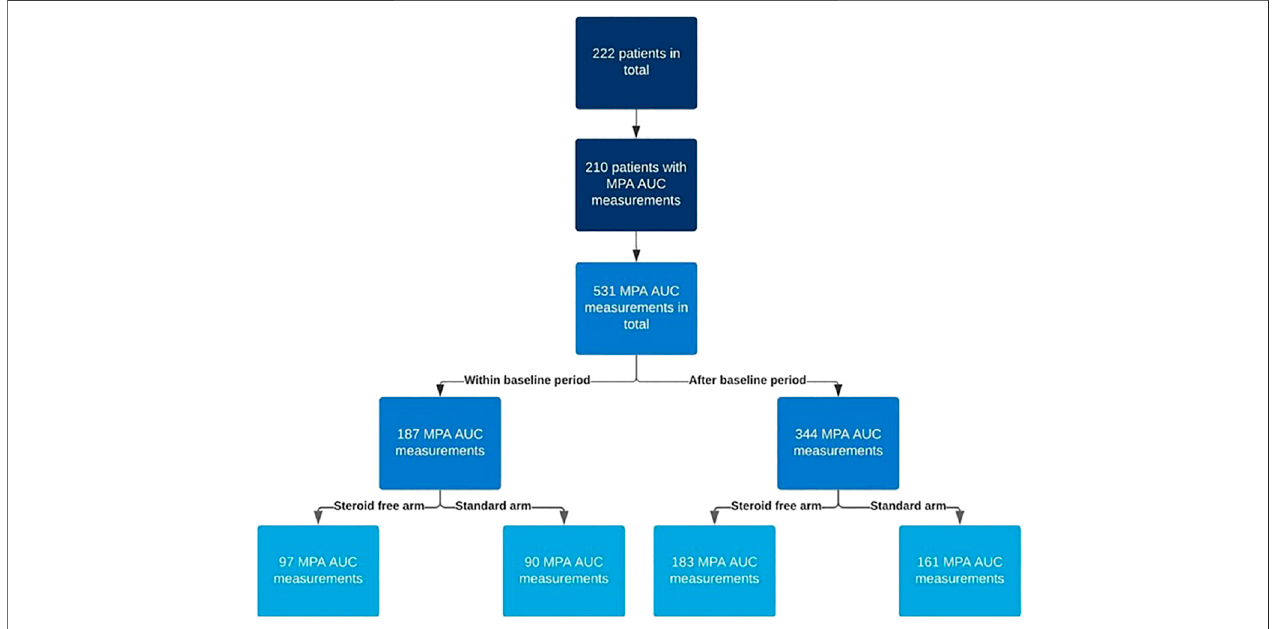
FIGURE 1 | Flow chart describing the number of mycophenolic acid area under the curve (MPA AUC) measurements in the two treatment arms (steroid-free and standard). The baseline period is the fi rst 2 weeks after transplantation.